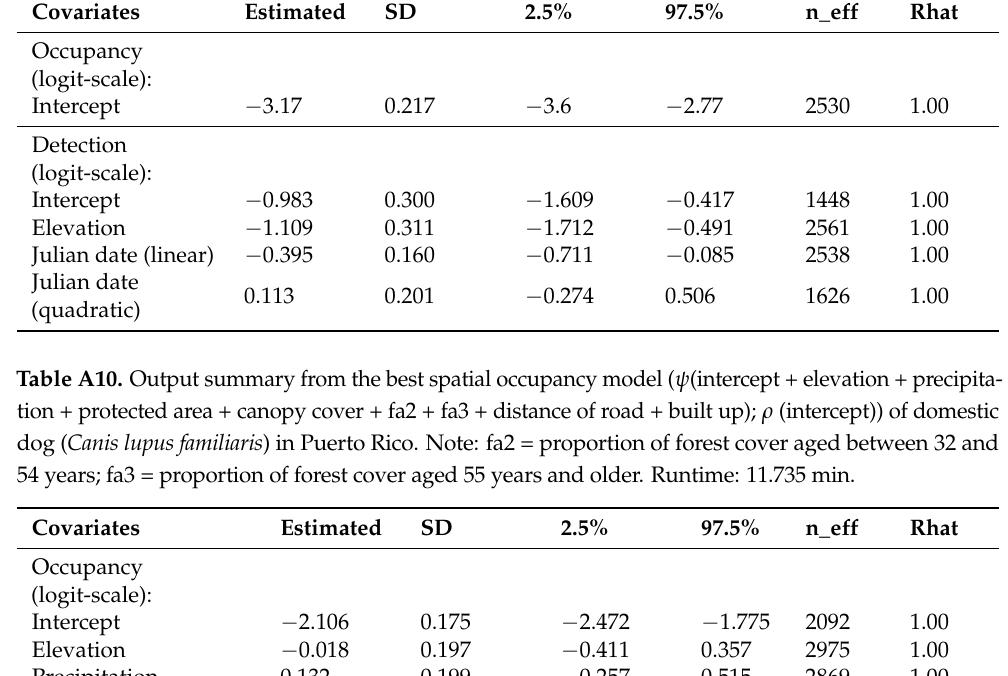
Table A9. Output summary from the best occupancy model ( ψ (intercept); ρ (intercept + elevation +